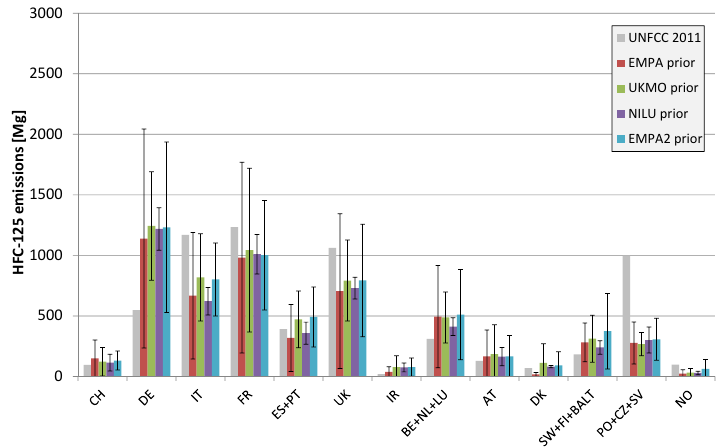
Figure 11. Country-aggregated prior emissions of HFC-125 (experiment M1). Country codes following ISO2 conventions except for BALT = Baltic countries (Estonia, Latvia, and Lithuania). CH = Switzerland, DE = Germany, IT = Italy, FR = France, ES = Spain, PT = Portugal, UK = United Kingdom, IR = Ireland, BE = Belgium, NL = Netherlands, LU = Luxembourg, AT = Austria, DK = Denmark, SW = Sweden, FI = Finland, PO = Poland, CZ = Czech Republic, SV = Slovakia, NO = Norway.